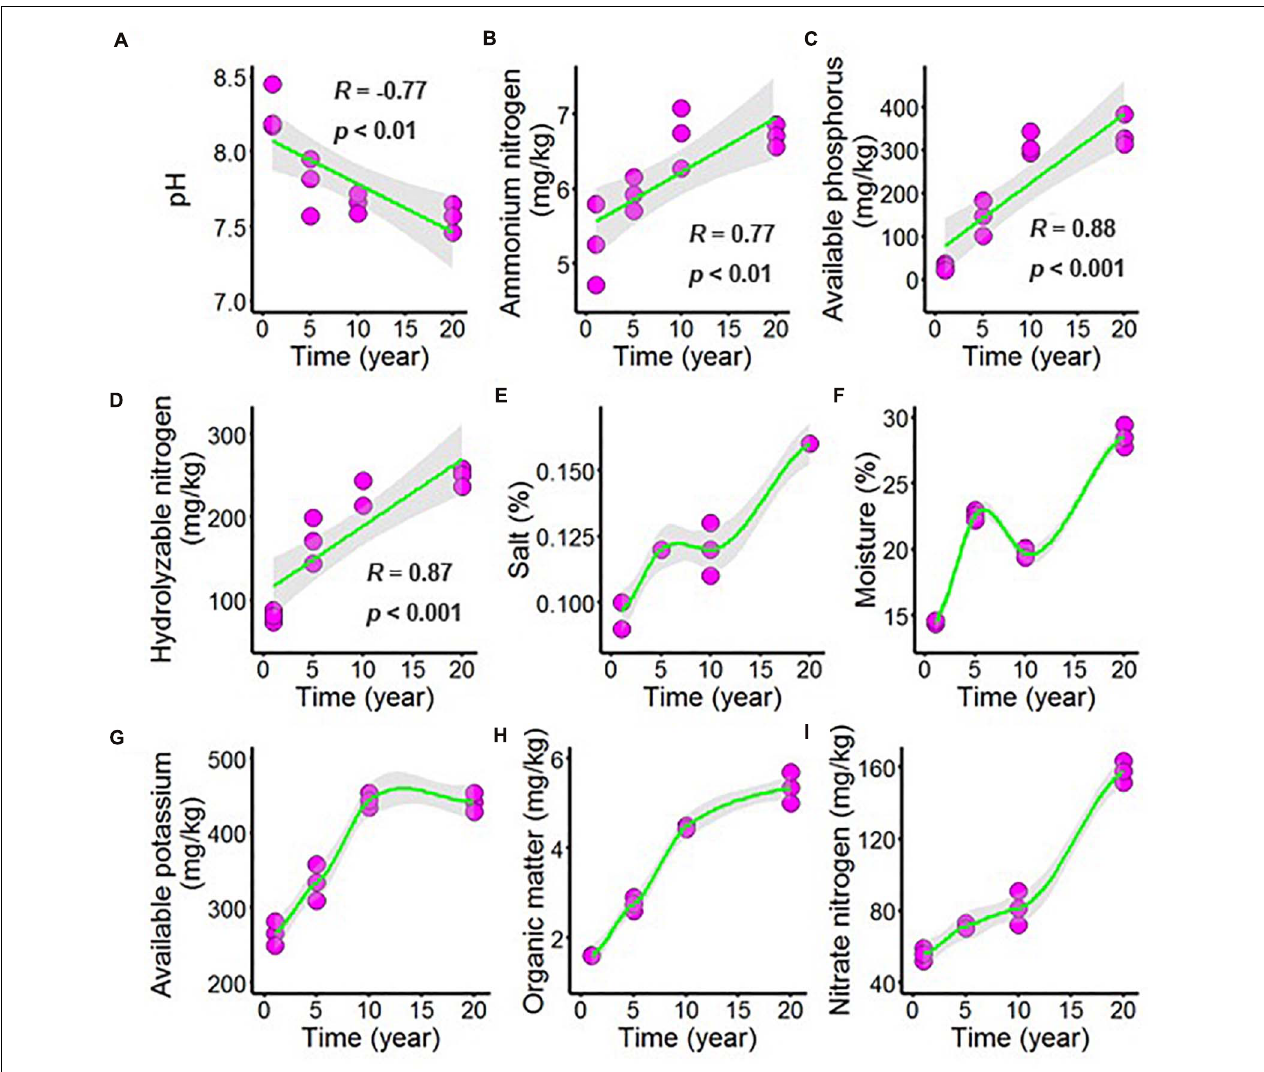
FIGURE 1 | Effect of long-term chili monoculture on the chemical properties of rhizosphere soil. Long-term chili monoculture altered the pH (A) , ammonium nitrogen (B) , available phosphorus (C) , hydrolyzable nitrogen (D) , salt (E) , moisture (F) , available potassium (G) , organic matter (H) , and nitrate nitrogen (I) . Soil chemical properties show different patterns of response to continuous cropping duration (1, 5, 10, and 20 years), including linear and nonlinear relationships. Solid lines represent linear or locally estimated scatterplot smoothing (LOESS) fits, and gray areas denote the 95% confidence